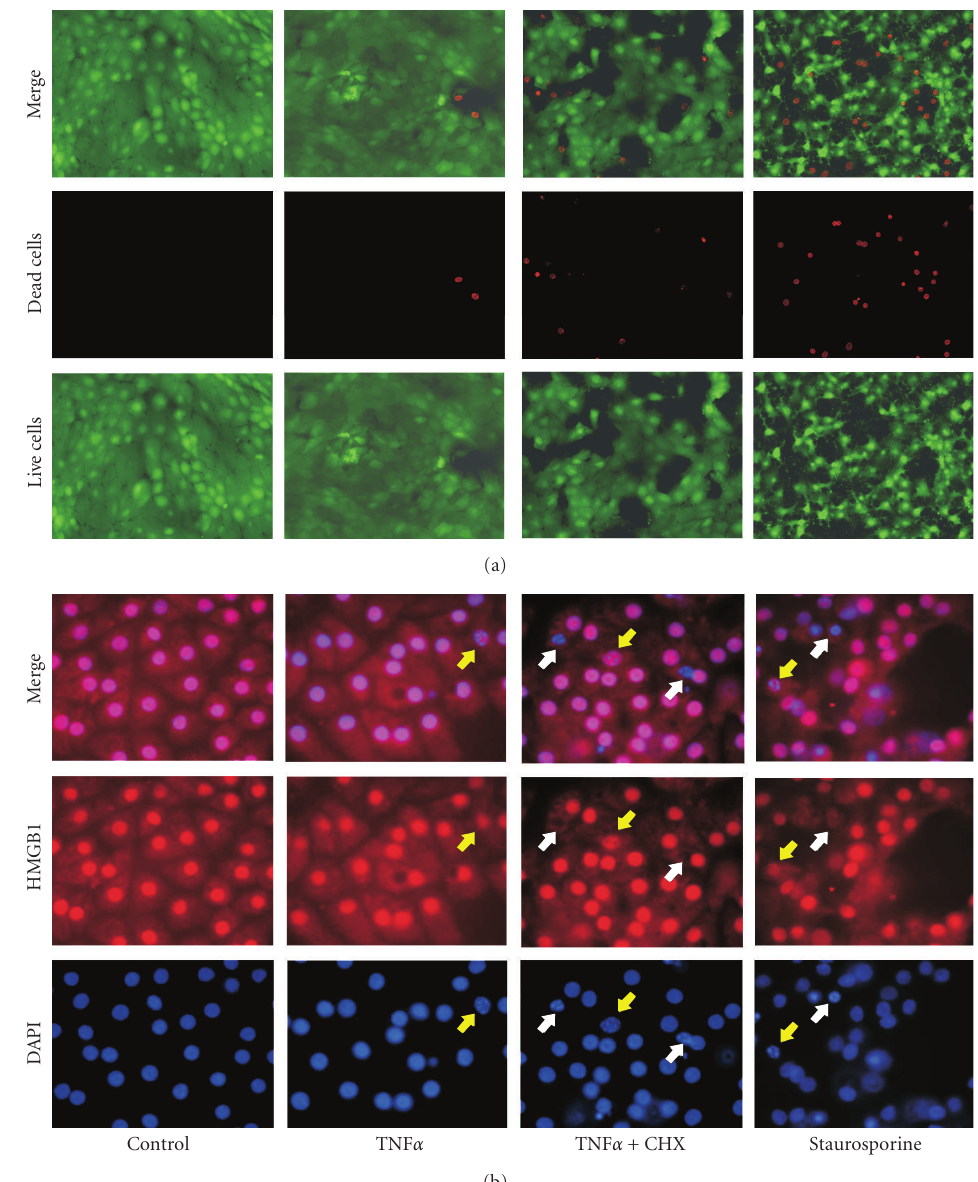
Figure 8: TNF α induces HMGB1 release as well as HBGB1 binding in PCPEC. TNF α -stimulated PCPEC loose membrane integrity. PCPEC were stimulated with TNF α (100ng/mL) ± cycloheximide (CHX) (1 μ g/mL) for 10 hours. For a positive control PCPECs were treated with staurosporine (1 μ M). (a) Adherent cells were labelled according to the Live/Dead assay protocol. Vital cells are penetrated by calcein and show a green fluorescence, damaged cells were penetrated by ethidium homodimer and show red fluorescent nuclei. Images were obtained by fluorescence microscopy (400 × magnification) using a digital camera. (b) Chromatin of vital and apoptotic cells binds HMGB1 (red) whereas TNF α ± CHX and staurosporine stimulated PCPEC partly released HMGB1 from nuclei (i.e., post-apoptotic necrosis; white arrows). DAPI staining revealed also that TNF α ± cycloheximide (CHX) resulted in chromatin condensation in PCPEC and binding of HMGB1 (i.e., apoptosis; yellow arrows). Both were detected by fluorescence microscopy (1000 × magnification) and photographs were taken using a digital camera. The whole well was examined for each experimental condition in two separate experiments; results from one representative experiment are